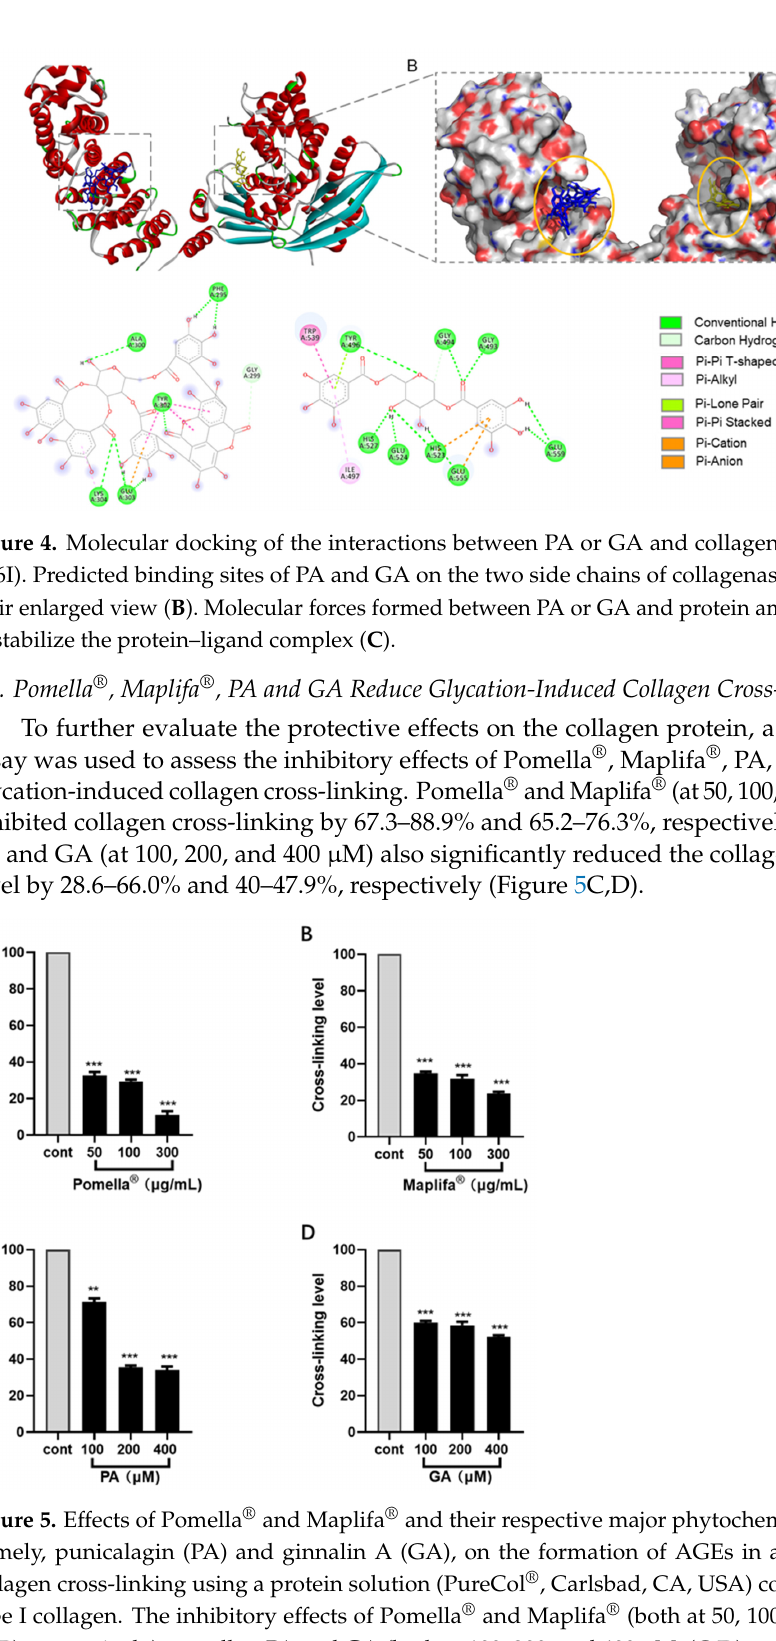
( A , B ), respectively) as well as PA and GA (both at 100, 200, and 400 µ M; ( C , D ), respectively) on the